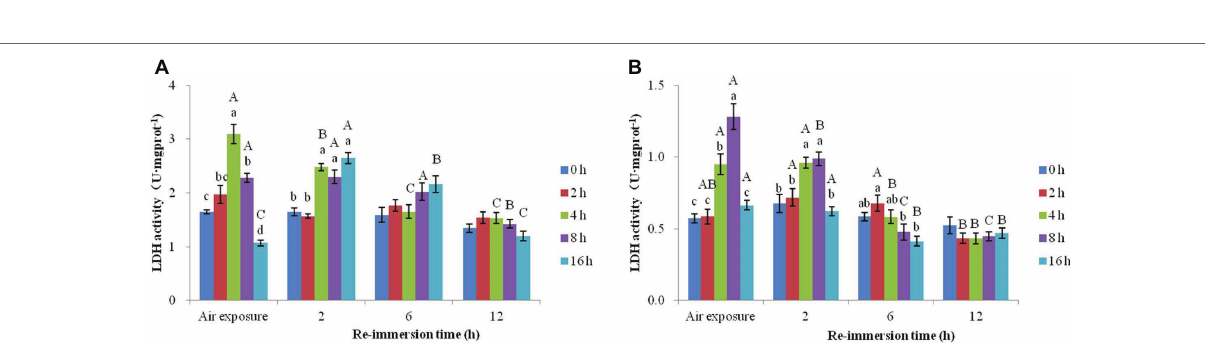
FIGURE 2 | Effects of air exposure and reimmersion on succinate dehydrogenase (SDH) in the gills (A) and hepatopancreas (B) of Chinese mitten crab. Different lowercase letters represent a significant difference between the different air exposure times at the same reimmersion time ( p < 0.05). Different uppercase letters represent a significant difference between the different reimmersion times at the same air exposure time ( p < 0.05).